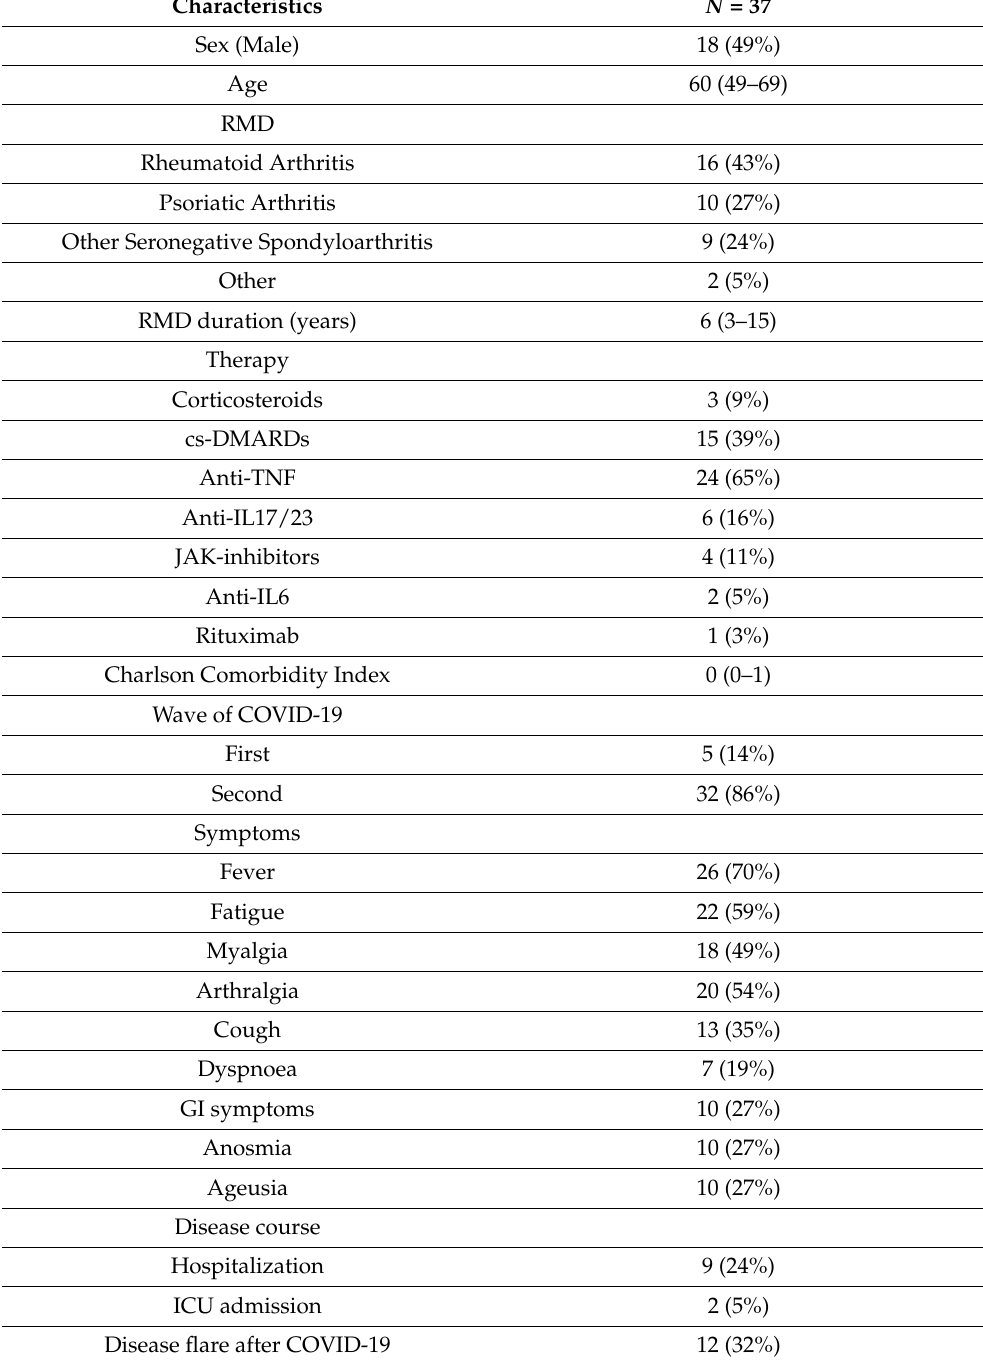
Table 3. Characteristics of RMD patients suffering from